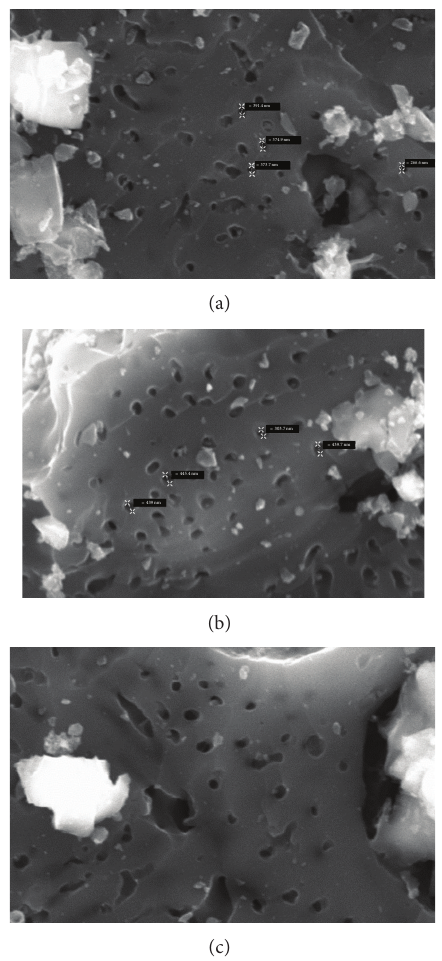
Figure 7: SEM photograph of oil-palm shell activated carbon prepared at (a) 500 ∘ C, (b) 600 ∘ C, and (c) 700 ∘